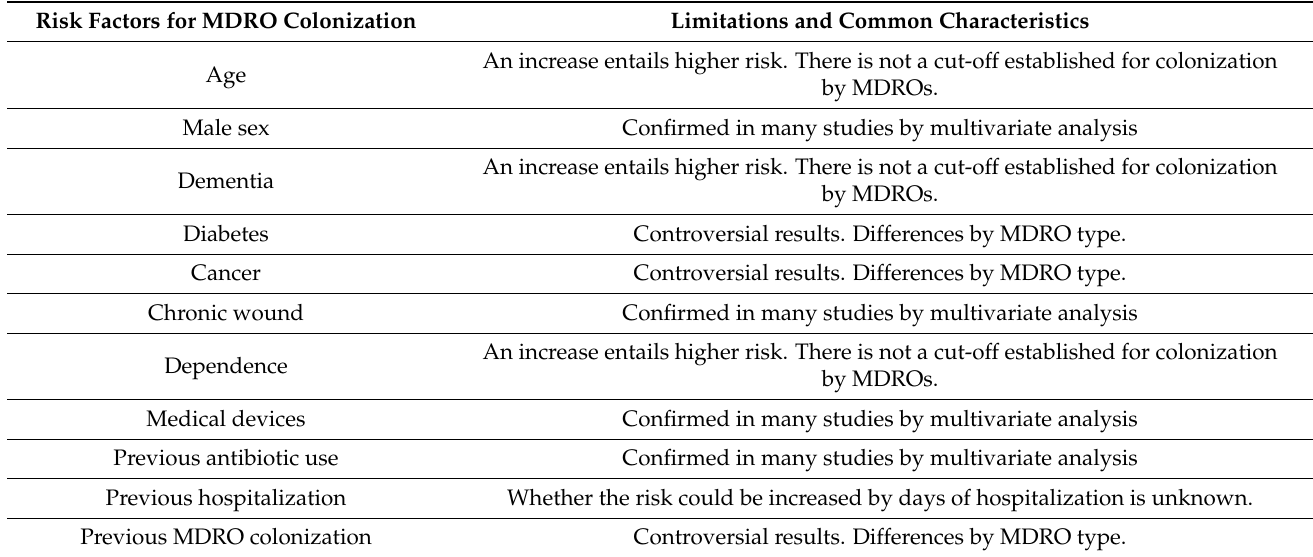
Table 3. Risk factors for multidrug-resistant organism colonization in long-term care facilities in the studies. Common characteristics and